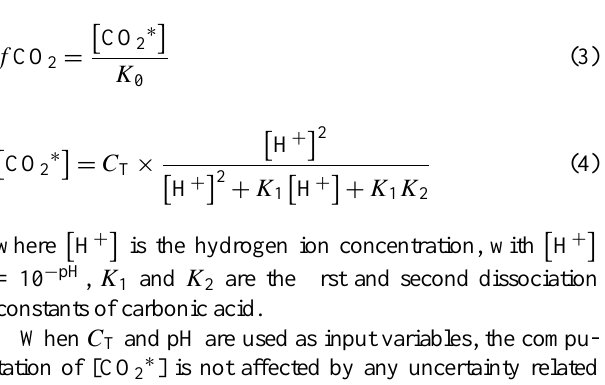
(solid T ,C T ) (dotted T , pH ) 3